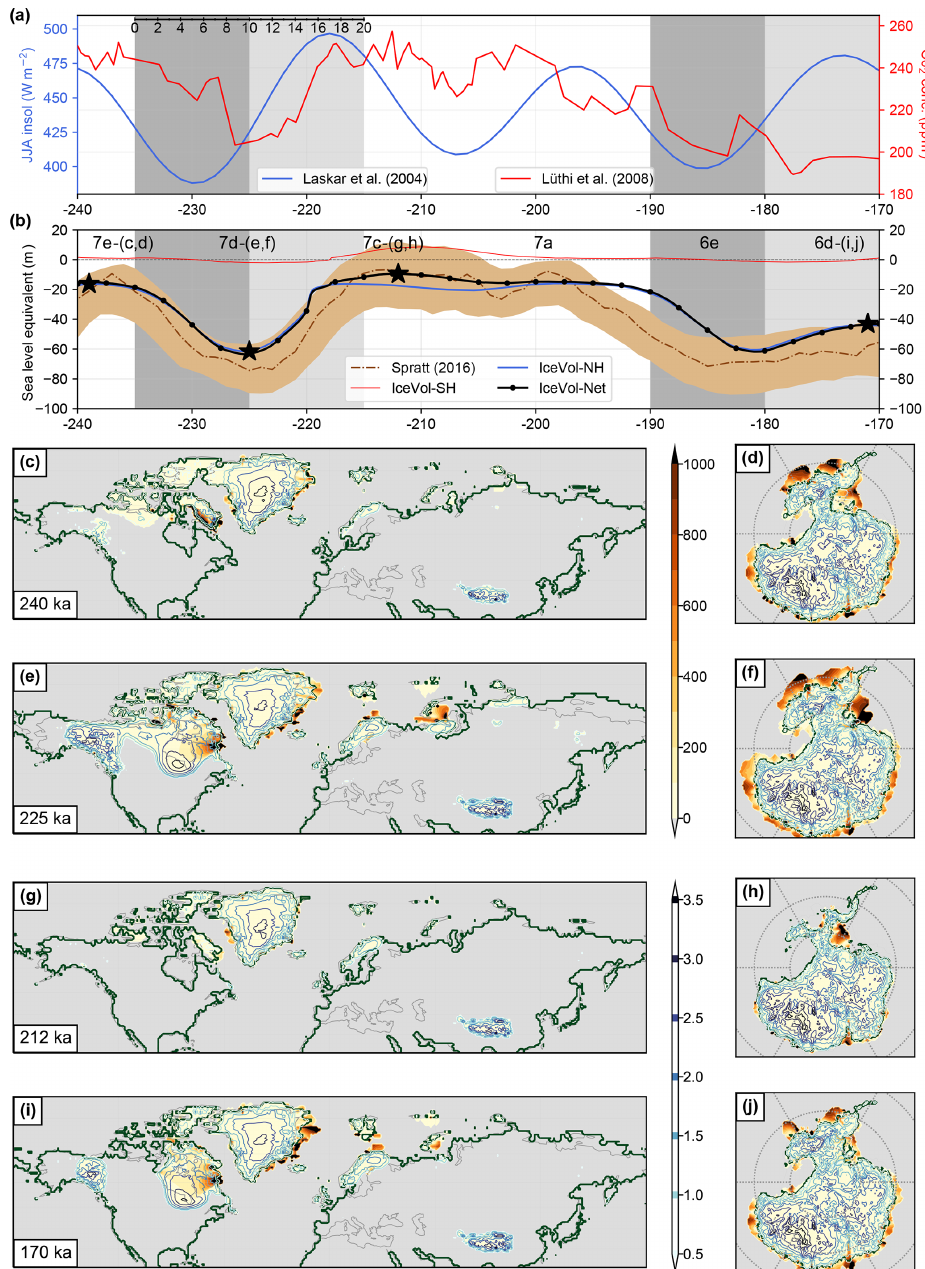
Figure 4. Maps of ice height and ice velocity from our transient coupled climate–ice sheet simulation over MIS 7. (a) JJA mean insolation at 65 ◦ N (Wm − 2 ; blue; Laskar et al., 2004) and CO 2 concentration (ppm; red; Lüthi et al., 2008). The dark-grey and light-grey patches in the backgrounds of (a) and (b) refer to two 20kyr periods leading into a glacial inception (10kyr) and immediately after a glacial inception (10kyr). The duration of these periods (20kyr) is marked by a small scale on the top left and used in Fig. 6. (b) Global sea level estimates (m) from Spratt and Lisiecki (2016) (brown) and sea level equivalent of ice volume from SH (red), NH (blue), and total (black) from our transient simulation. The marked stars on the simulated SLE represent four instances corresponding to MIS 7e (240ka), MIS 7d (225ka), MIS 7c (212ka), and MIS 6 (170ka). (c) Basal ice velocity (solid colors; myr − 1 ), ice thickness (colored contours; km), and the grounding line (solid green lines) for the Northern Hemisphere at 240ka, initial condition. (d) Same as (c) but for the Southern Hemisphere. (e, f) Same as (c) and (d) but for 225ka. (g, h) Same as (c) and (d) but for 212ka. (i, j) Same as (c) and (d) but for